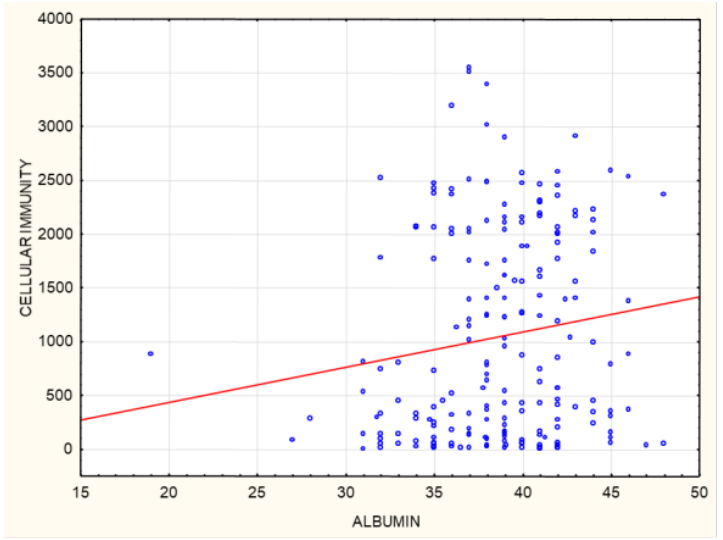
Figure 19. Positive correlation between cellular immunity (INF γ concentration mIU/mL) at 1 month